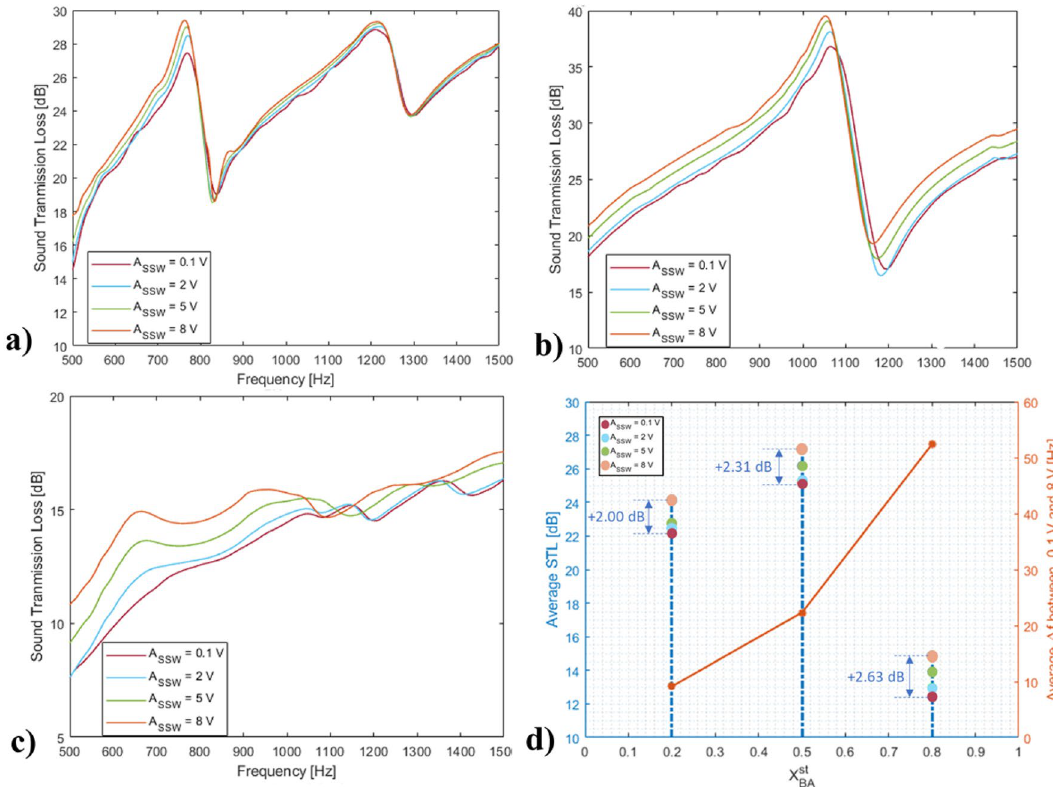
st = 0.2; ( b ) X st = 0.5; ( c ) BA BA